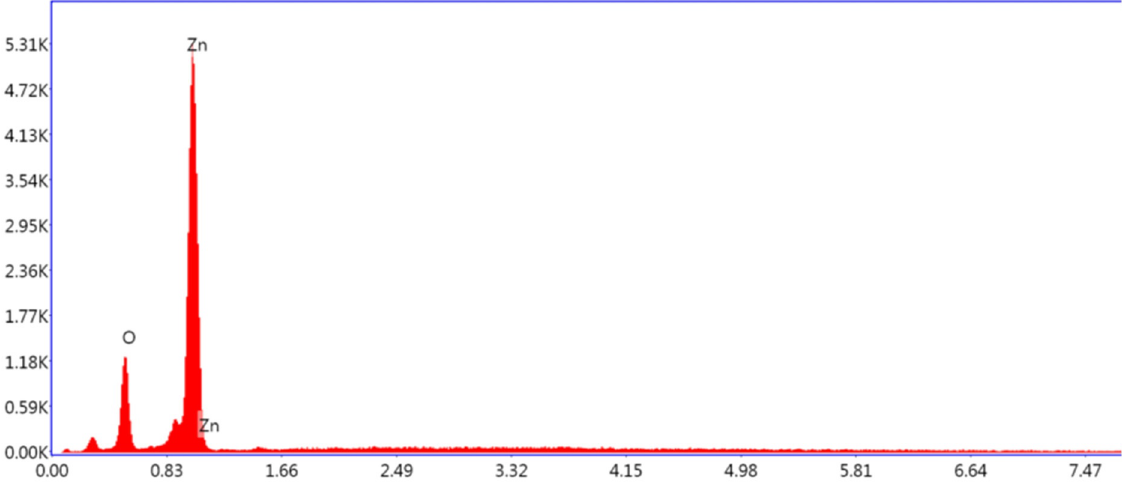
Figure 10. Energy-dispersive X-ray (EDX) spectrum of green-synthesized ZnO NPs using the leaf extract of A. indica .